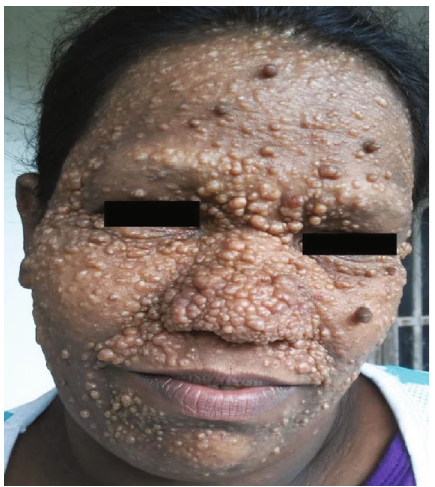
Figure 1: A 15-year-old patient presenting with multiple facial papules.